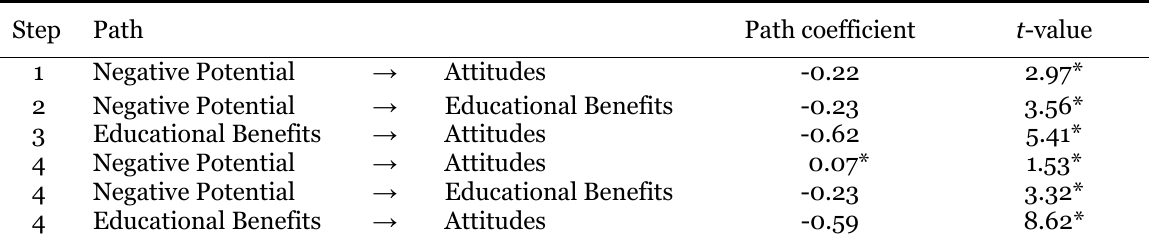
Student Results for Negative Potential, Educational Benefits, and